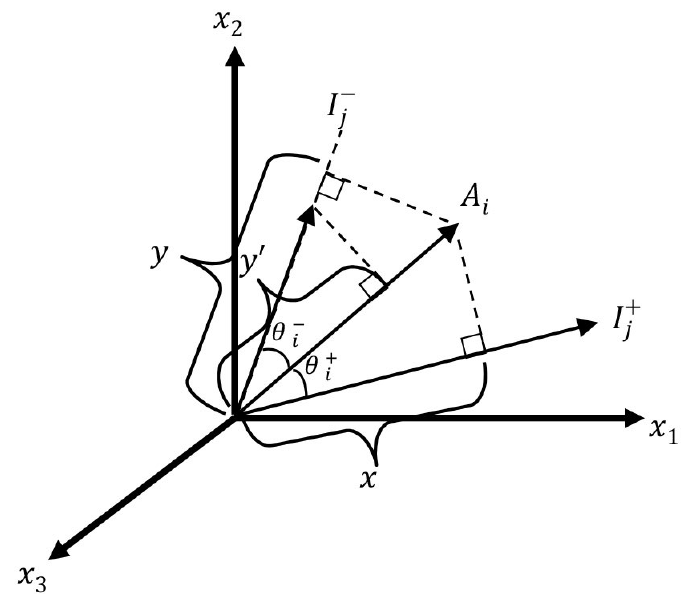
Figure 2. The degree of conflict between alternatives and I j+ (I j–